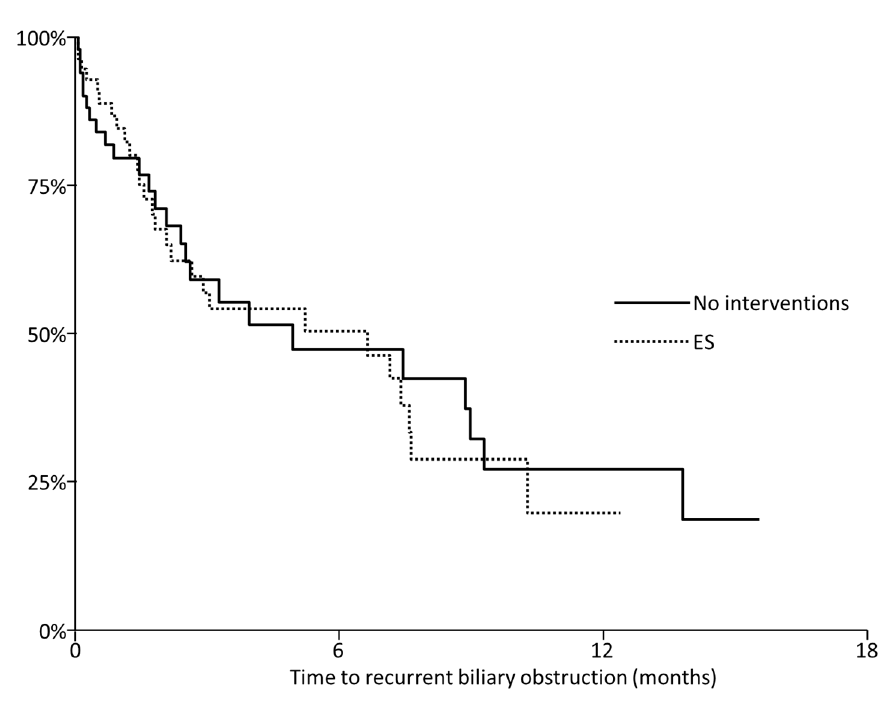
Figure 3. Kaplan-Meier curves of recurrent biliary obstruction according to the ampullary interventions in benign biliary strictures ( a ) and malignant biliary strictures ( b ). Solid line: No interventions, dotted line: ES (endoscopic sphincterotomy), Dashed line: EPBD (endoscopic papillary balloon dilation).